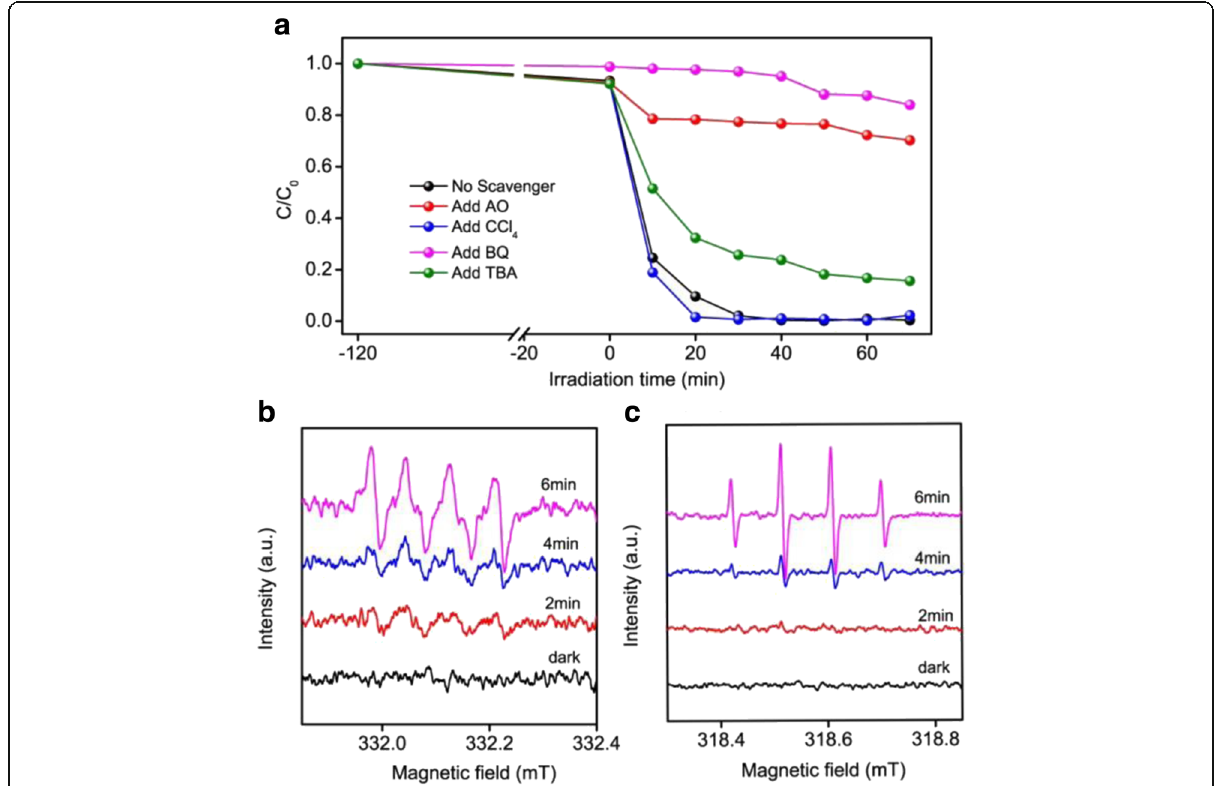
Fig. 8 Effects of different scavengers on methyl orange degradation in the presence of SnNb 2 O 6 under visible light irradiation ( a ). EPR spectra obtained from SnNb 2 O 6 containing 0.22 M DMPO and 4.0 mg catalyst with total volume of 90% methanol/10% water ( b ) and 2 mL water ( c ) under different visible light irradiation